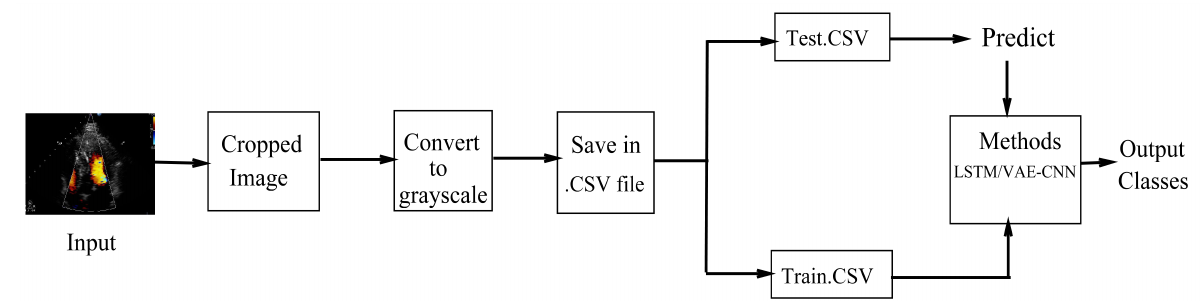
Figure 2. An overall flow chart showing the working methodologies used in our